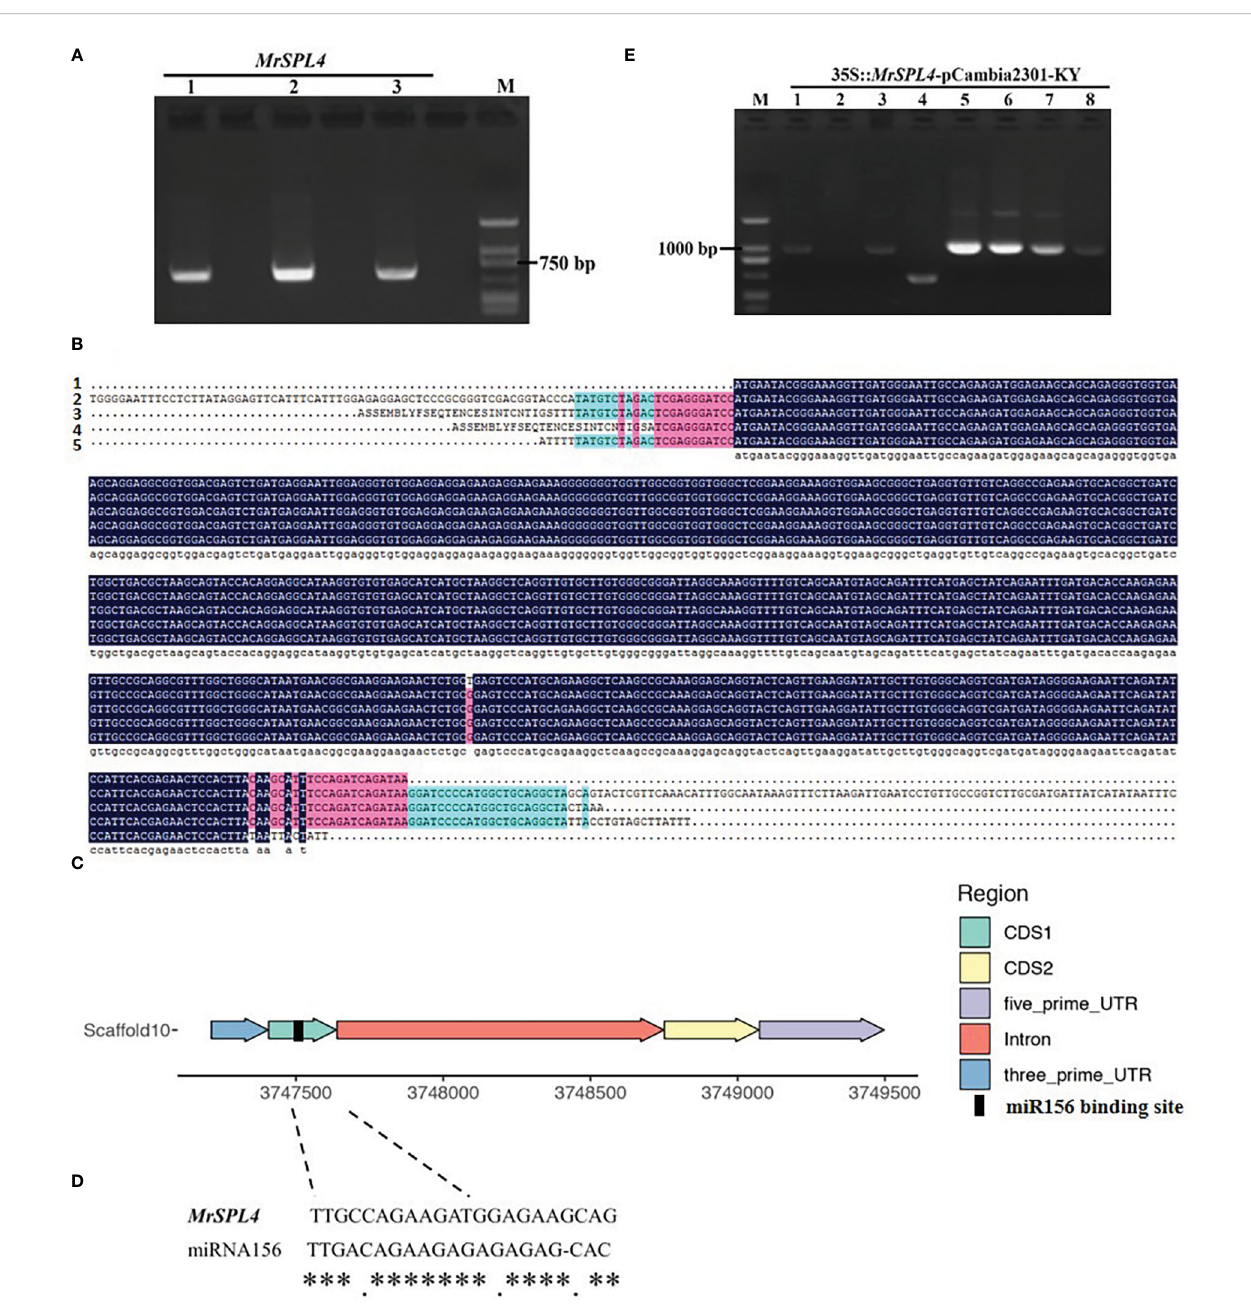
FIGURE 4 Cloning, sequence alignment, structure, miRNA156 target and construction of overexpression vector of MrSPL4 gene in different test materials. (A) The result of the coding region of MrSPL4 electrophoresis, M: DL2000 DNA marker, 1-3: MrSPL4 gene cloning in different samples. (B) The CDS sequence of MrSPL4 , 1 refers to genome sequence, and 2, 3, 4 and 5 refer to gene sequence in ZJ, ZJ, BQ and DK, respectively. (C) The gene structure of MrSPL4 . (D) The binding site of miRNA156 . ** represent the consistency of the binding site. (E) The PCR identifying result of the transformed bacterial solution,